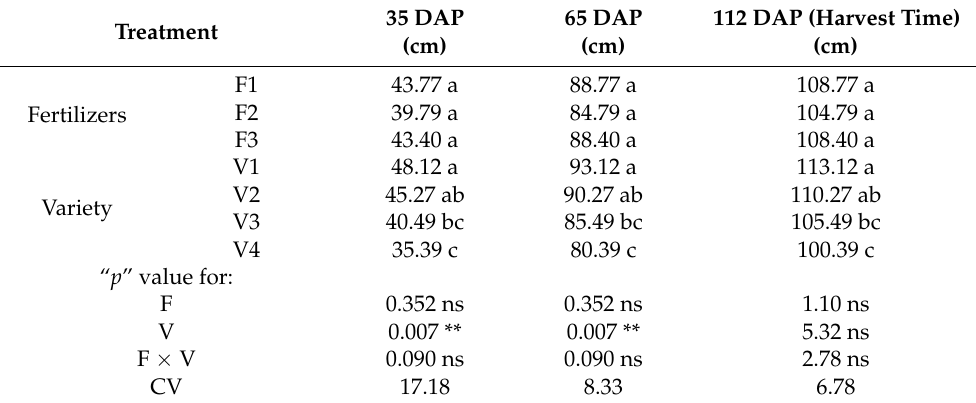
Table 4. Plant height of the treatments of the study in karst dryland, Gunungkidul, WS 2019/2020. Treatment